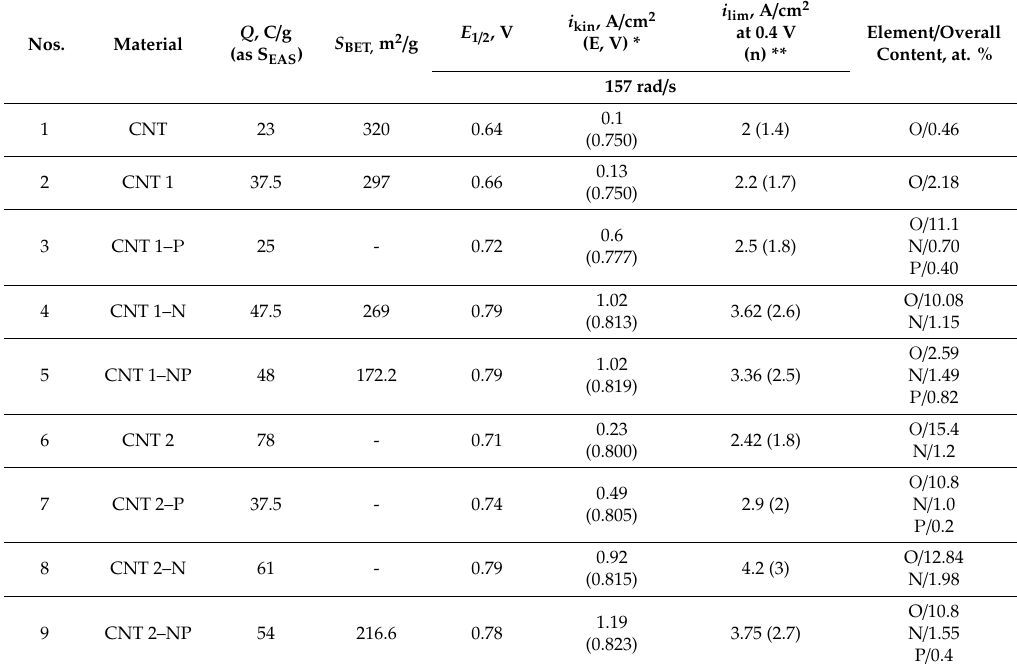
Table 1. Characteristic parameters of CNTs after various types of